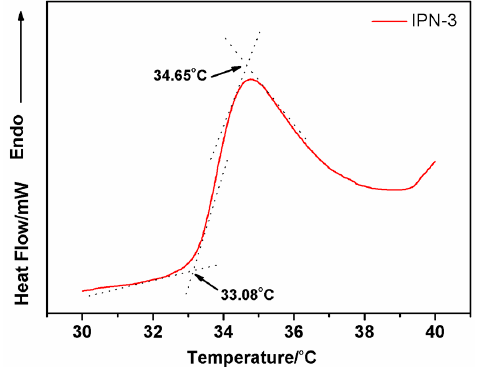
Figure 6. Determination of the LCST from a typical DSC thermogram of the IPN hydrogel.